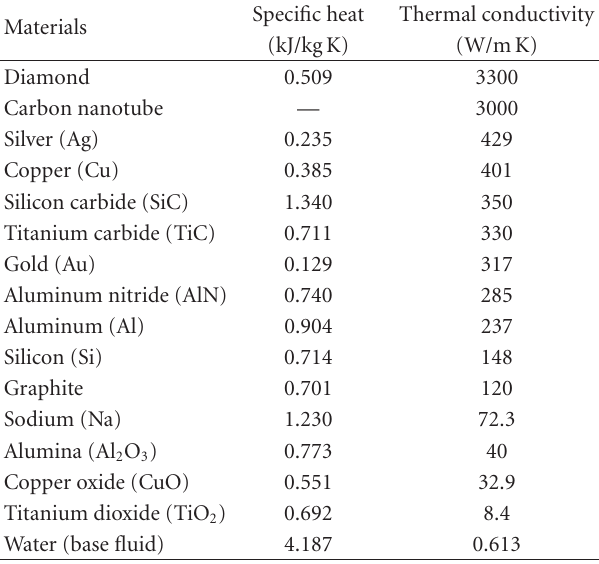
Table 1: Specific heat capacity and thermal conductivity for di ff erent materials